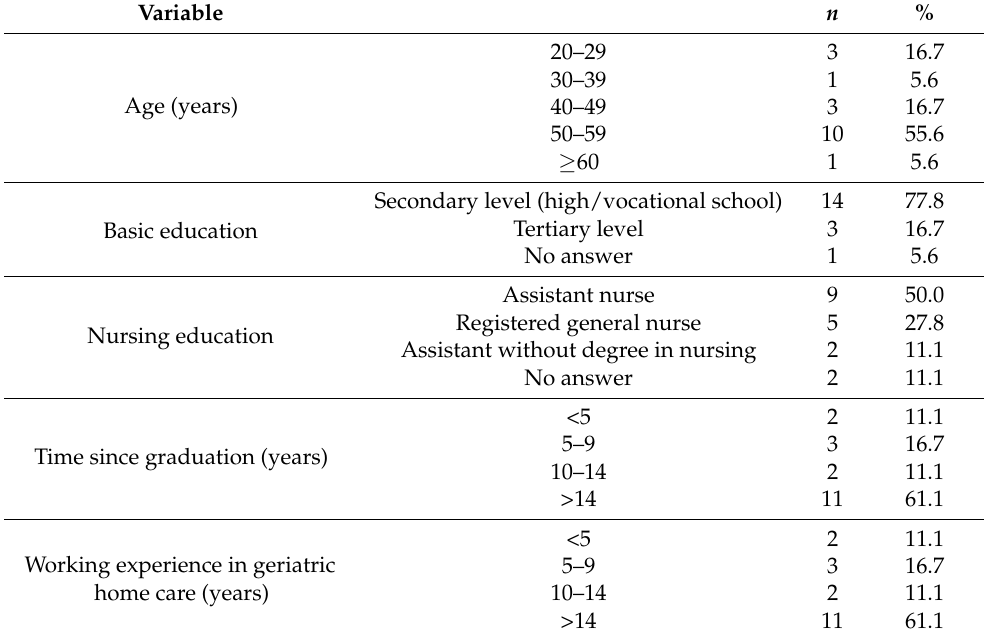
Table 2. Characteristics of the